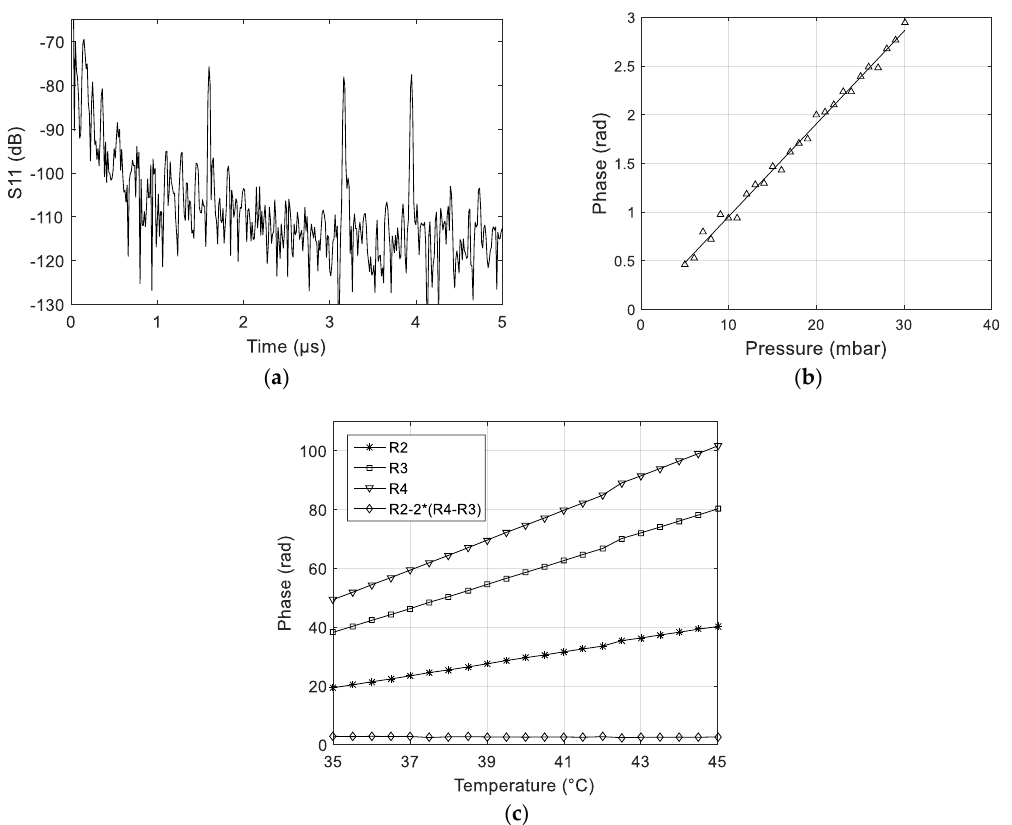
Figure 7. ( a ) LN/Si SAW R-DL response, in time domain; ( b ) Phase-shift vs. applied pressure; ( c ) Phase-shift vs. temperature (no applied pressure). The residual temperature sensitivity (diamond line) is close to zero.